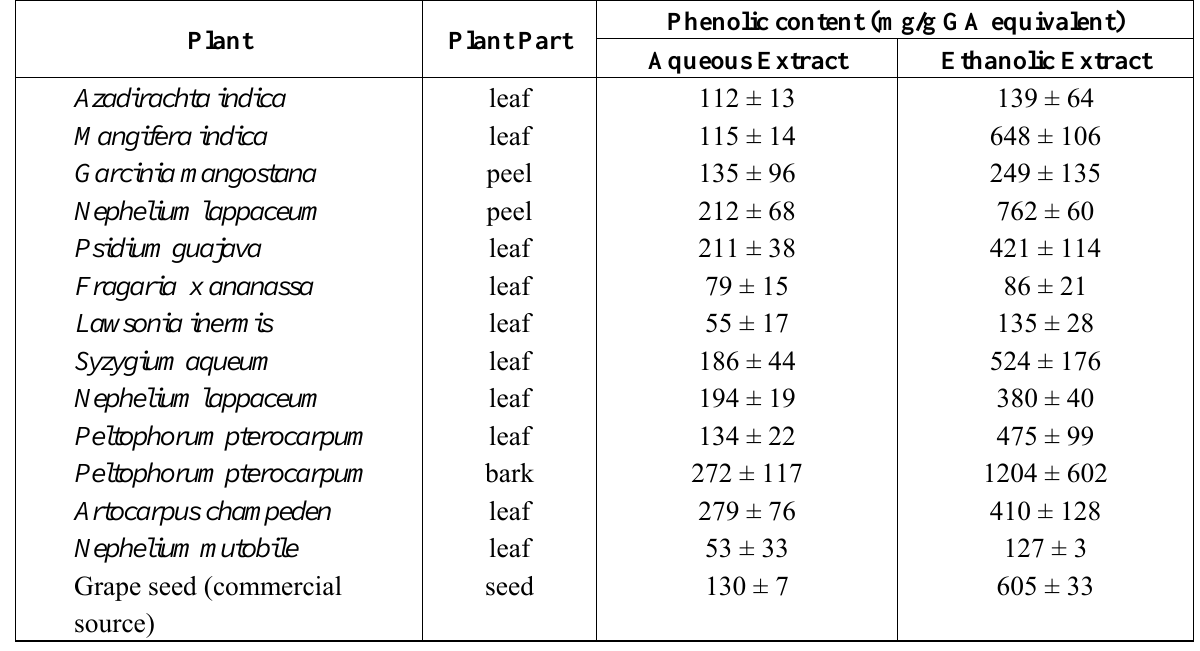
Table 1. Total Phenolic content of selected Malaysian